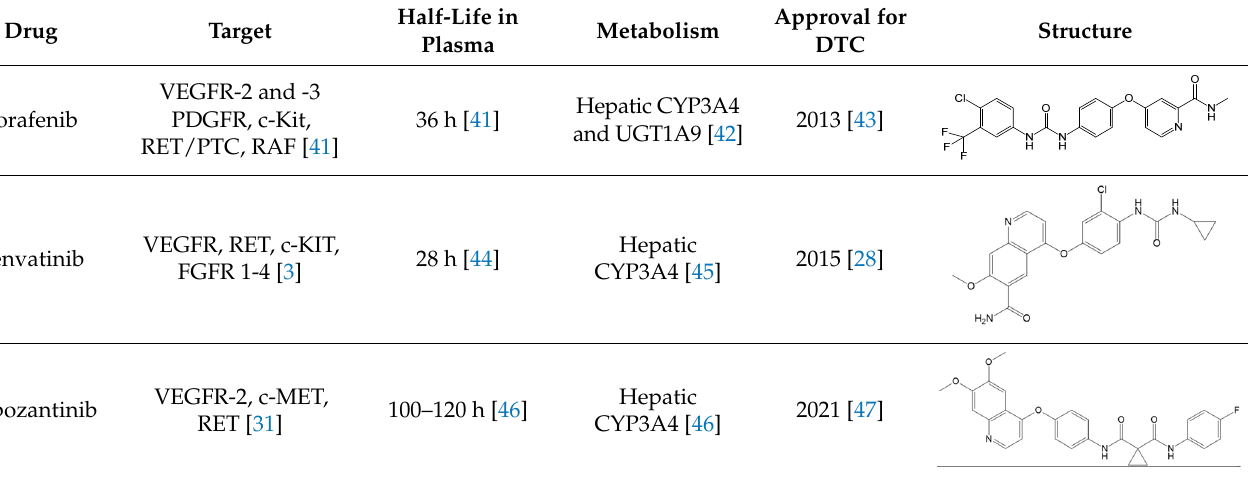
Table 1. Characteristics of sorafenib, lenvatinib, and cabozantinib.